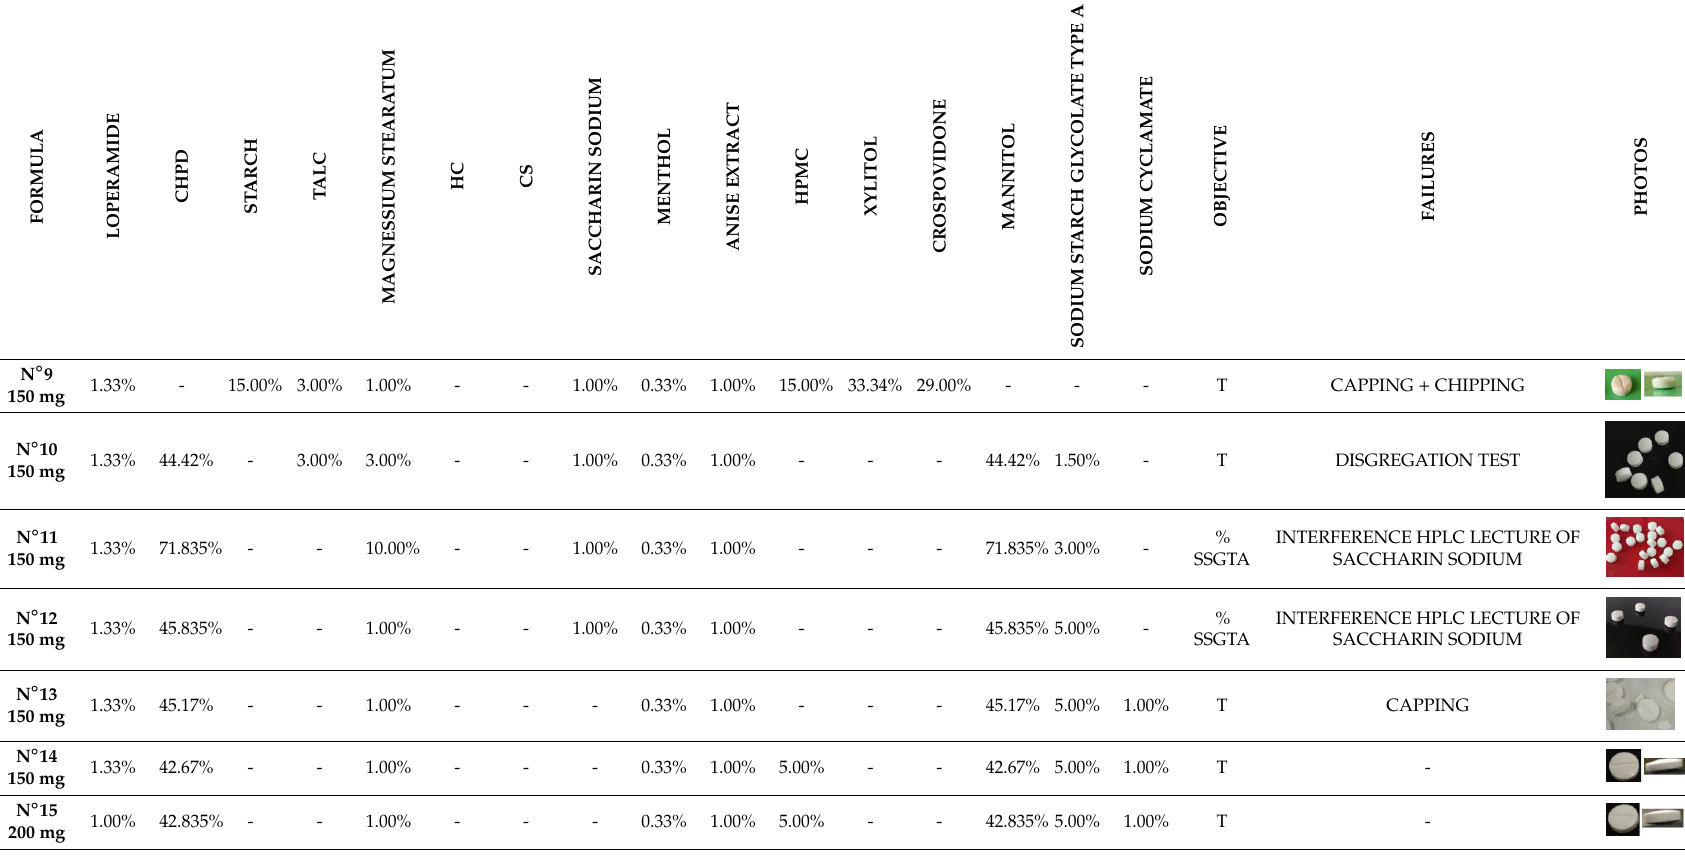
CHPD = CALCIUM HYDROGEN PHOSPHATE DIHYHIDRATE; CS = CROSCARMELLOSE SODIUM; ES = ECONOMIC